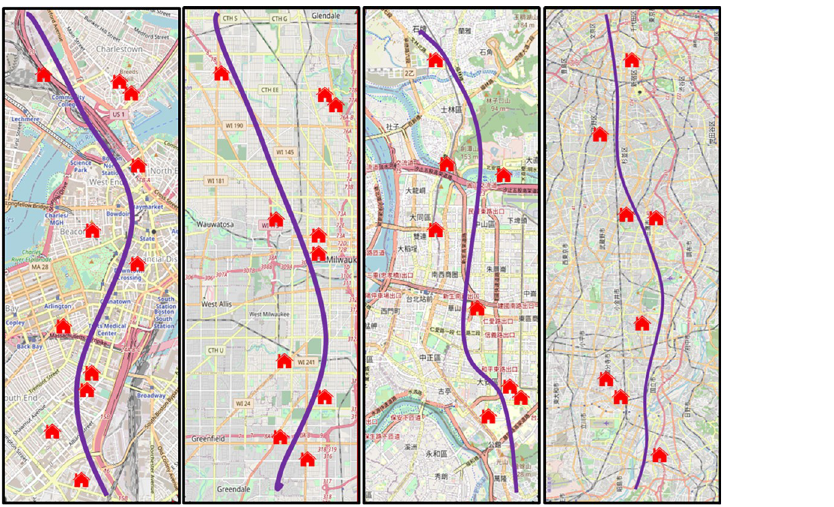
Fig 1. The selected routes in (a) Boston; (b) Milwaukee, (c) Taipei; and (d)